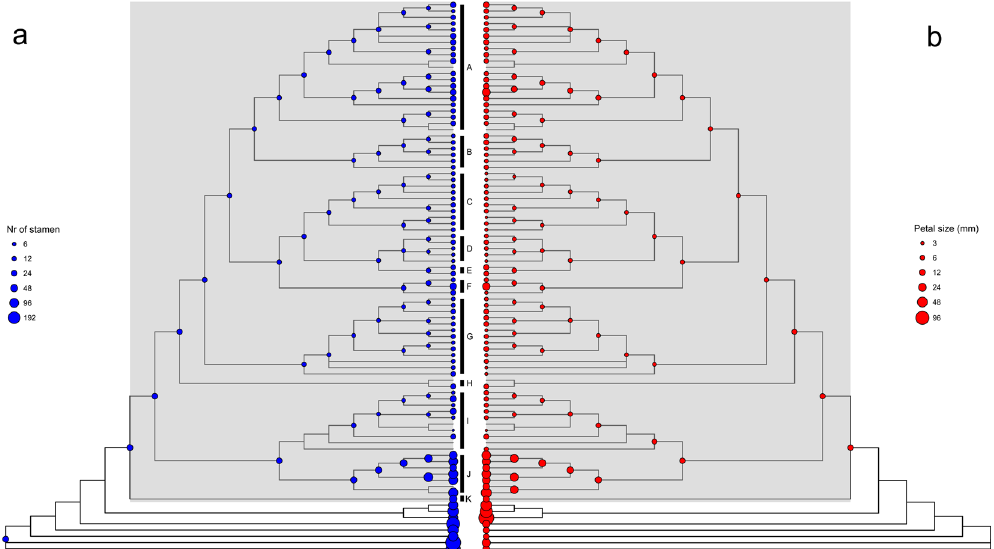
Figure 3. Number of stamens ( a ) and petal size in mm ( b ) plotted onto the Monanthotaxis phylogeny, with internal nodes showing Bayesian estimation of mean